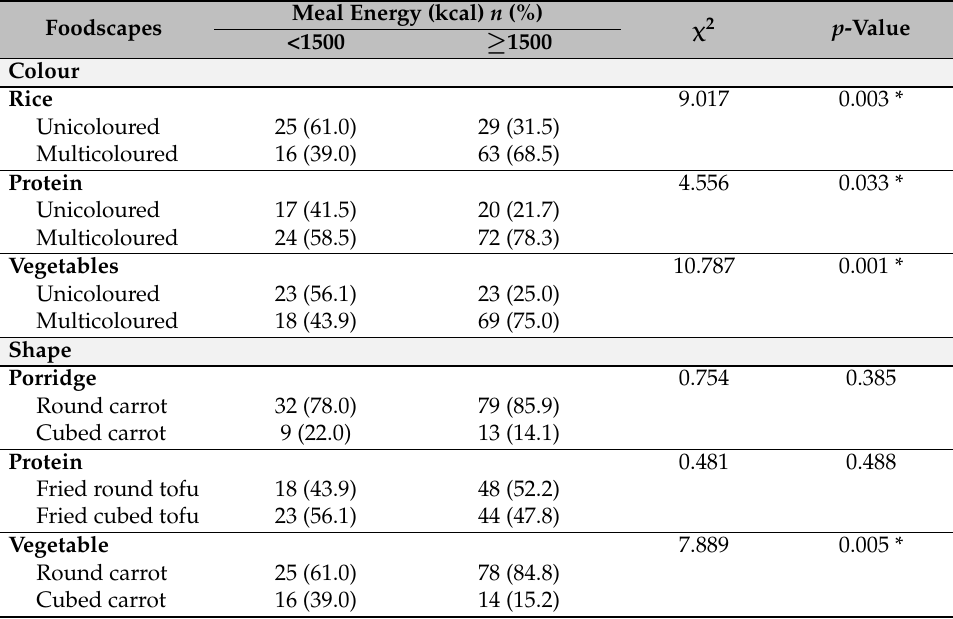
Table 14. Association between foodscapes (colour and shape) and total meal